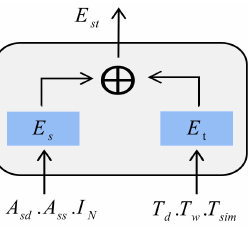
Figure 4. Static and dynamic spatio-temporal representation fusion (here A sd is the static distance graph of nodes, A ss is the dynamic similarity graph of nodes, and I N is the identity matrix; T d is the daily One-Hot static encoding of the time series, T w is the weekly One-Hot static encoding of the time series, and T sim is the dynamic similarity graph representation of the time